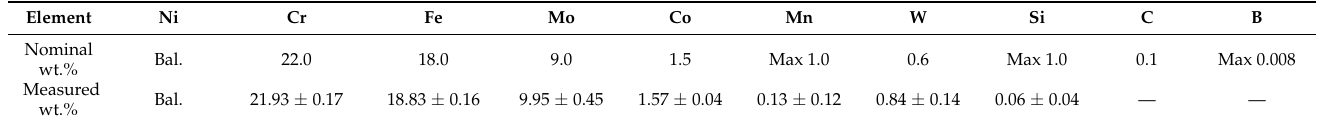
Table 1. Nominal and measured (EDS quantification) compositions of L-PBFed GH3536